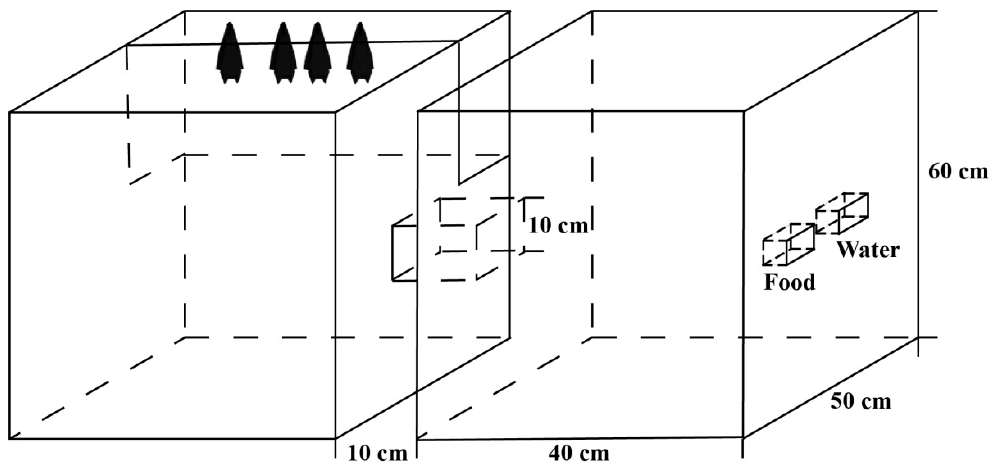
Figure 1. The two connected cages. One cage (the roosting cage), which served as a living environment, was covered with damp towels, while the other cage (the foraging cage) served as a feeding environment. Food and water dishes were used to provide mealworms and water. The two cages were connected by a channel with a length of 10 cm. The bat images in the figure represent only the position of the bats, not the exact number of individuals.